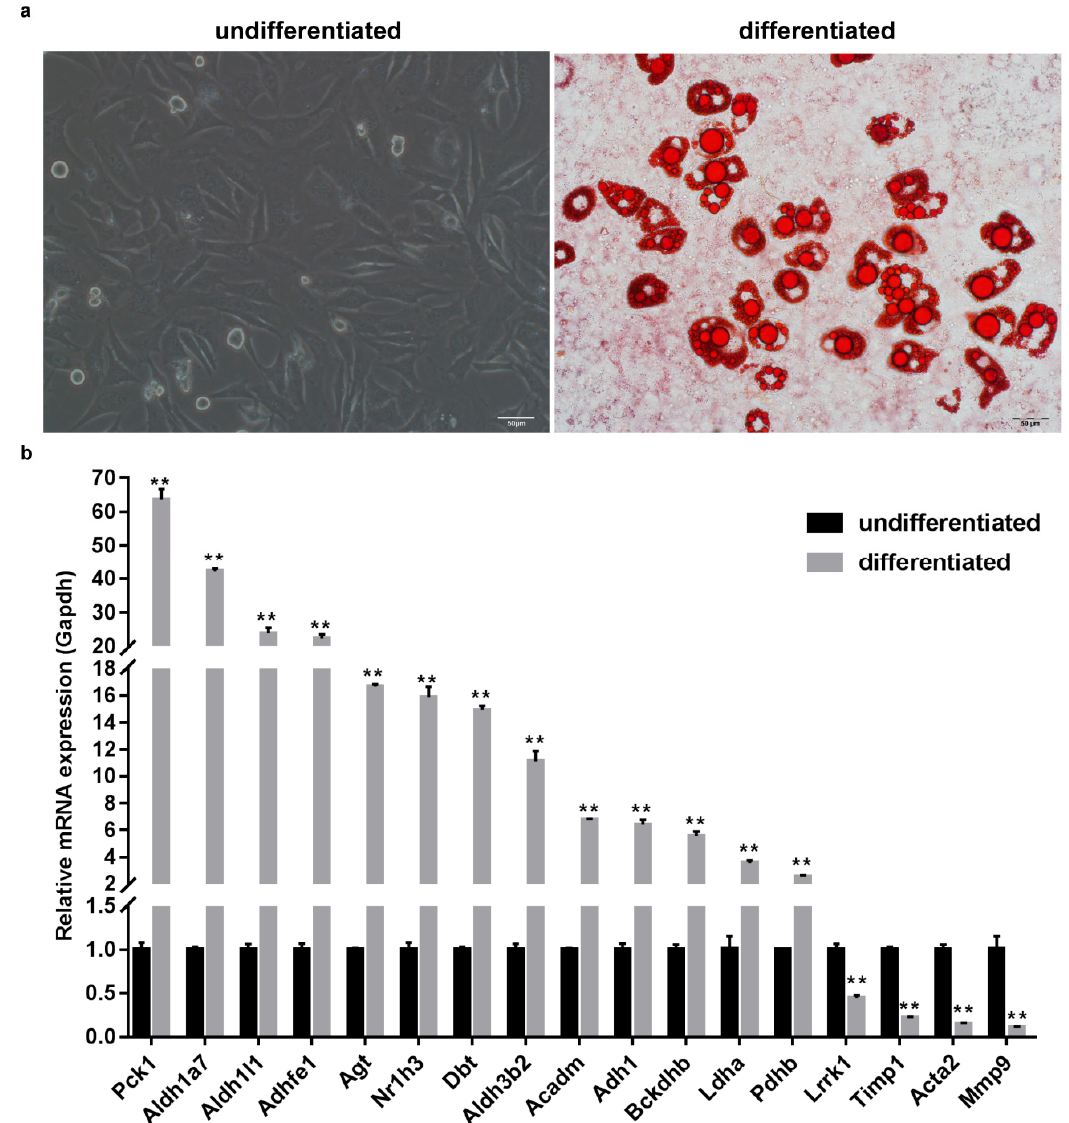
Figure 6. Verification of differential expression of key genes during 3T3-L1 preadipocyte differentiation. ( a ) Undifferentiated (Day 0) and differentiated (Day 8, Oil red O staining) 3T3-L1 cells under the induced differentiation process. ( b ) Relative expression levels of potential key genes were measured in undifferentiated and differentiated 3T3-L1 cells by qRT-PCR. Three independent experiments were performed for all of these groups, and the quantitative results are expressed as the mean ± SD of three independent experiments. ** indicates p < 0.01.